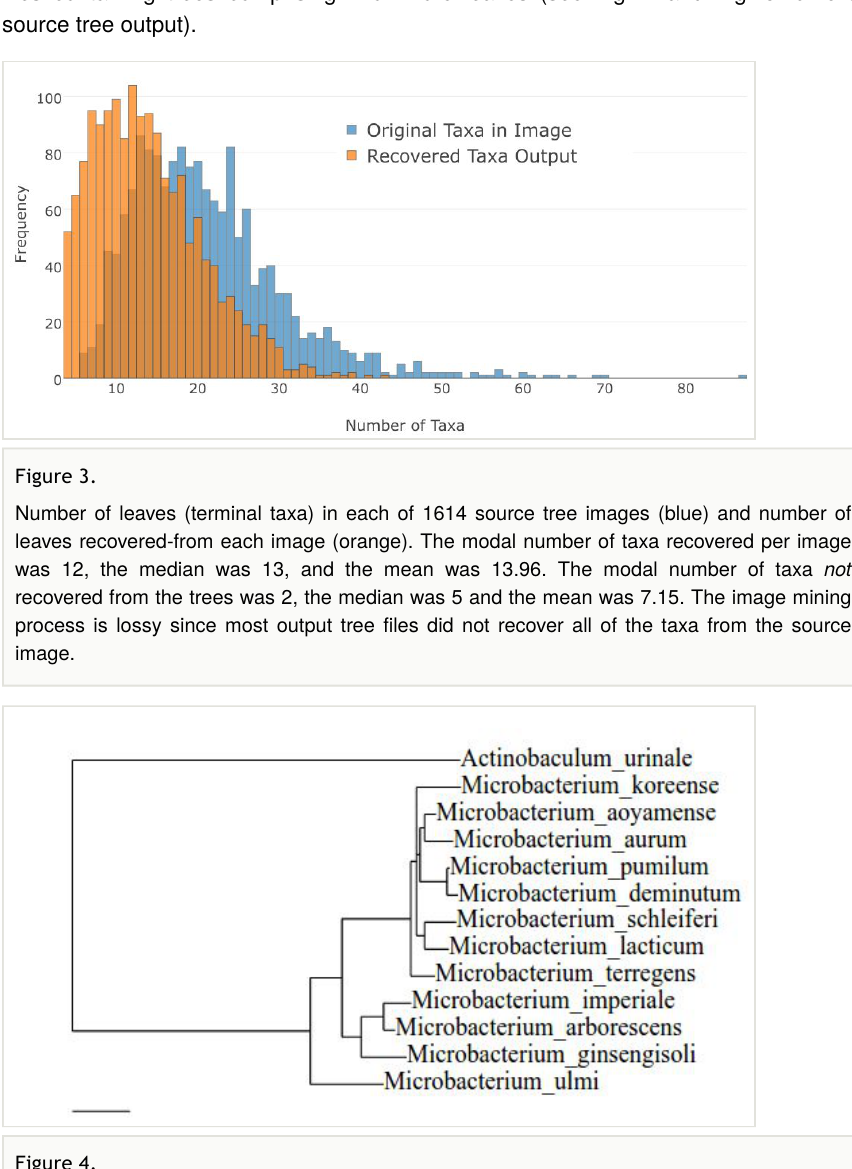
Output from image analysis of the input tree image in fi gure 1. All taxa and relationships are correctly reproduced, with branch lengths also preserved with high fi delity. (Note that the vertical ordering of the tips is not meaningful and is arbitrarily created by the display